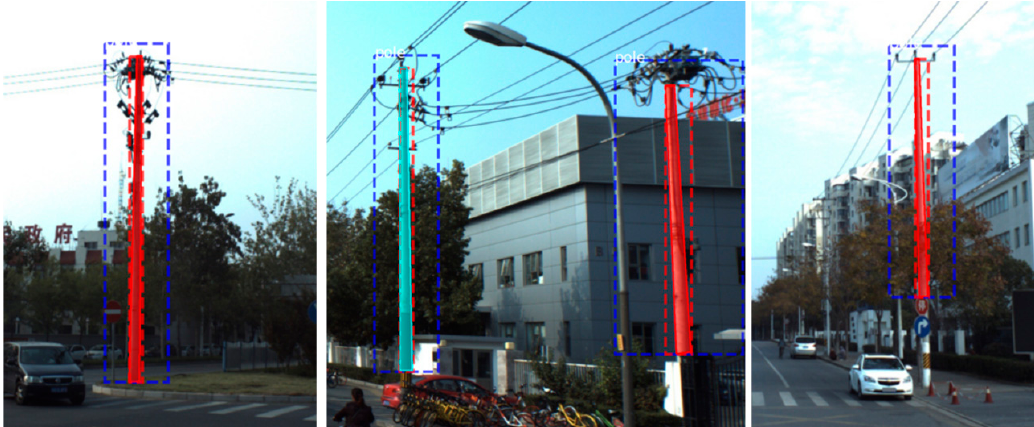
Figure 4. Comparison of original bounding box and expanded bounding box.